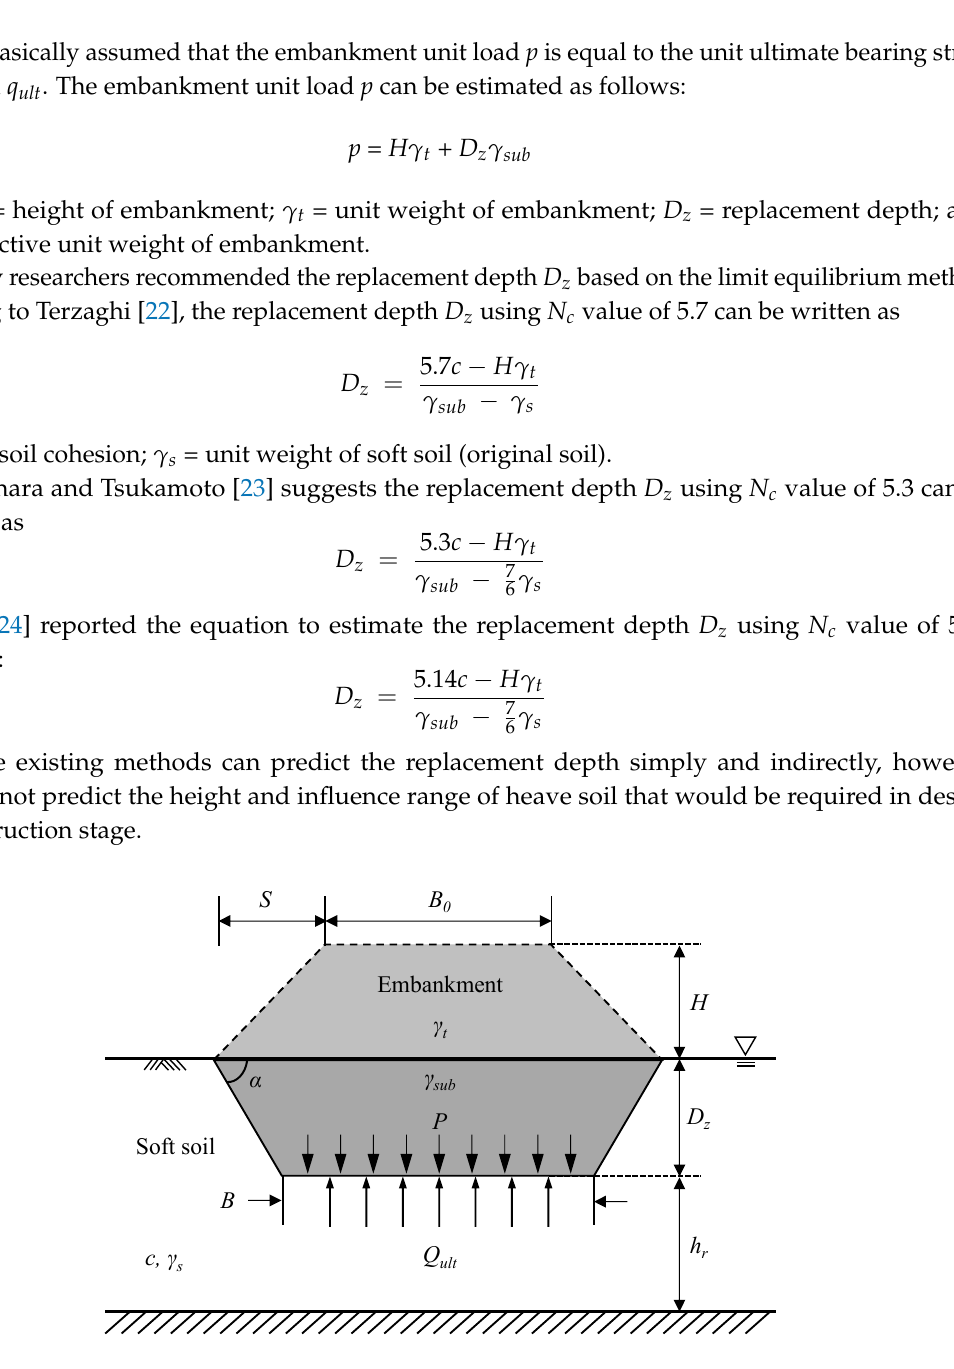
Figure 4. Schematic diagram of the forced replacement method.